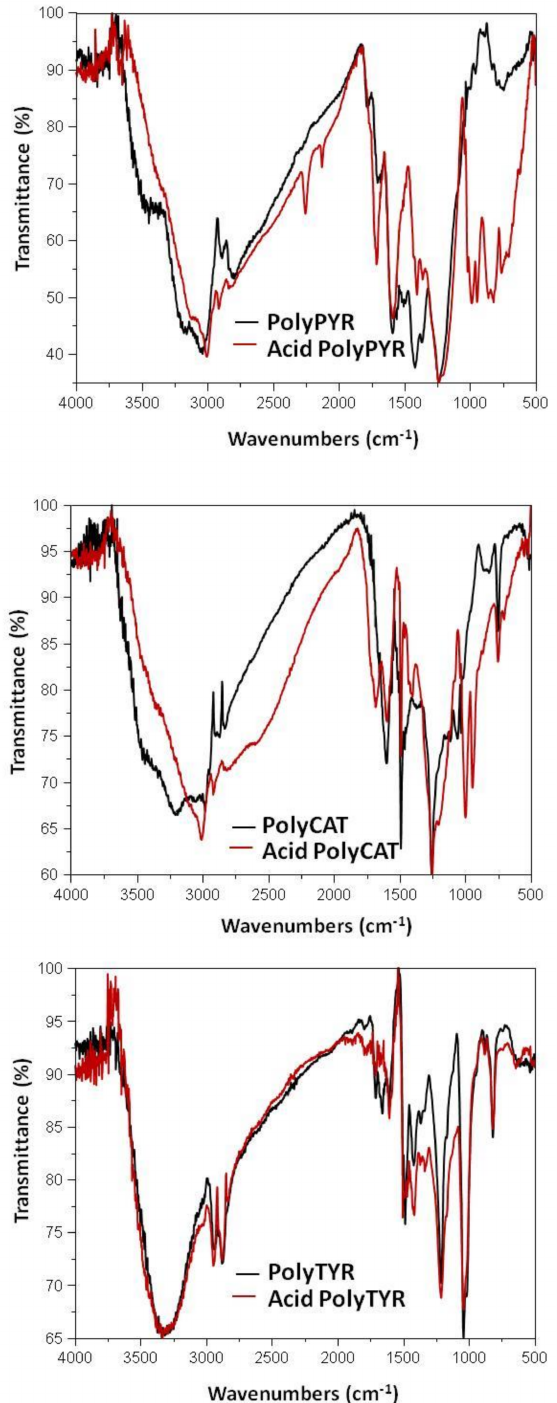
Figure 5. ATR-FTIR spectra of selected enzymatically synthesized phenolic polymers before ( black line ) and after ( red line ) the acid